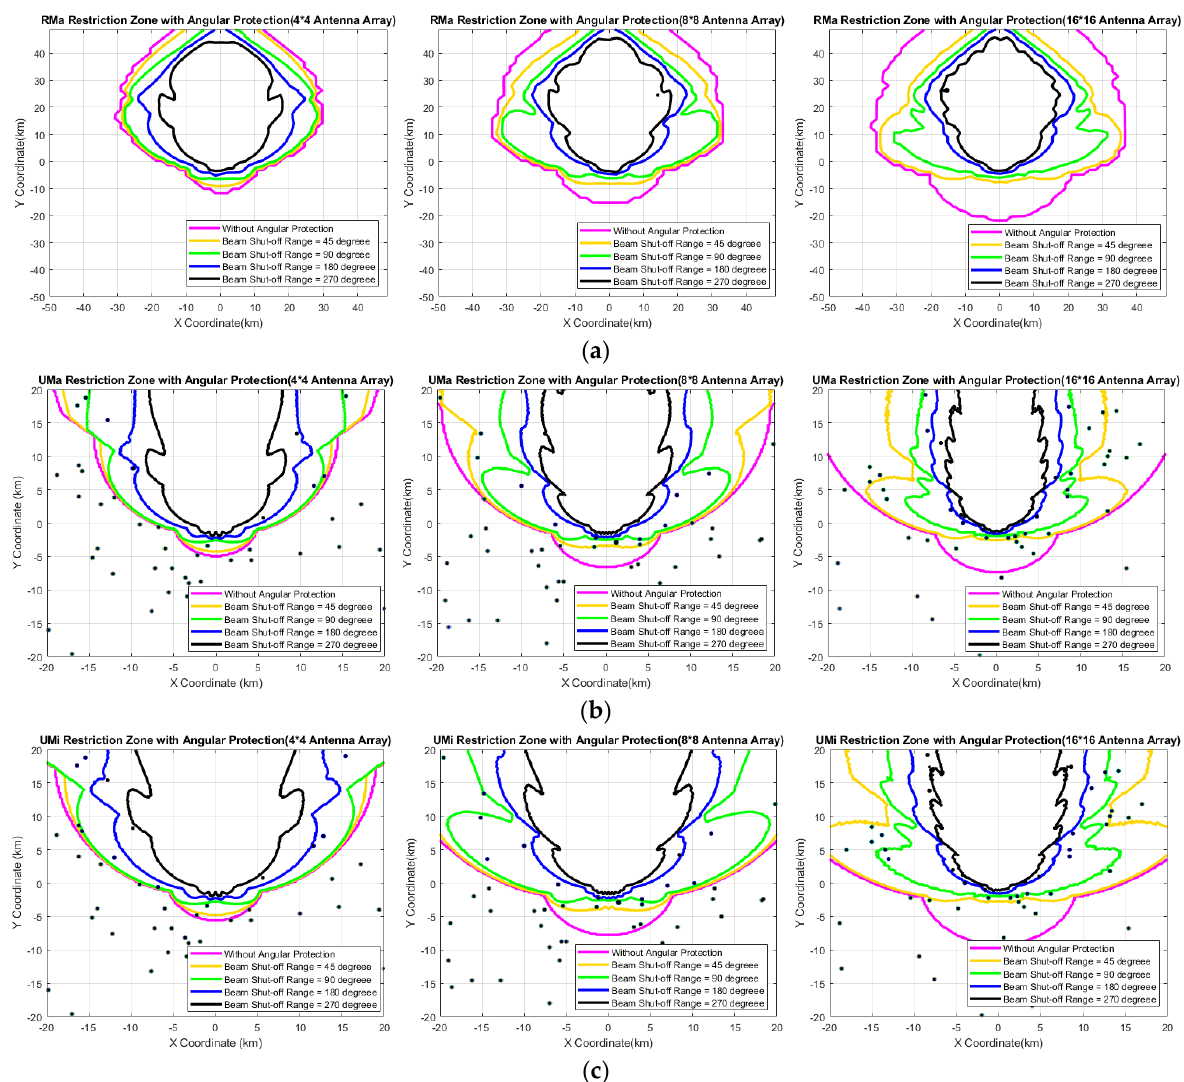
Figure 12. Restriction zone reduction using the proposed angular protection for antenna sizes in ( a ) RMa, ( b ) UMa, and ( c ) UMi. ( a ) Rural macrocell (RMa); ( b ) urban macrocell (UMa); ( c ) urban microcell (Umi).